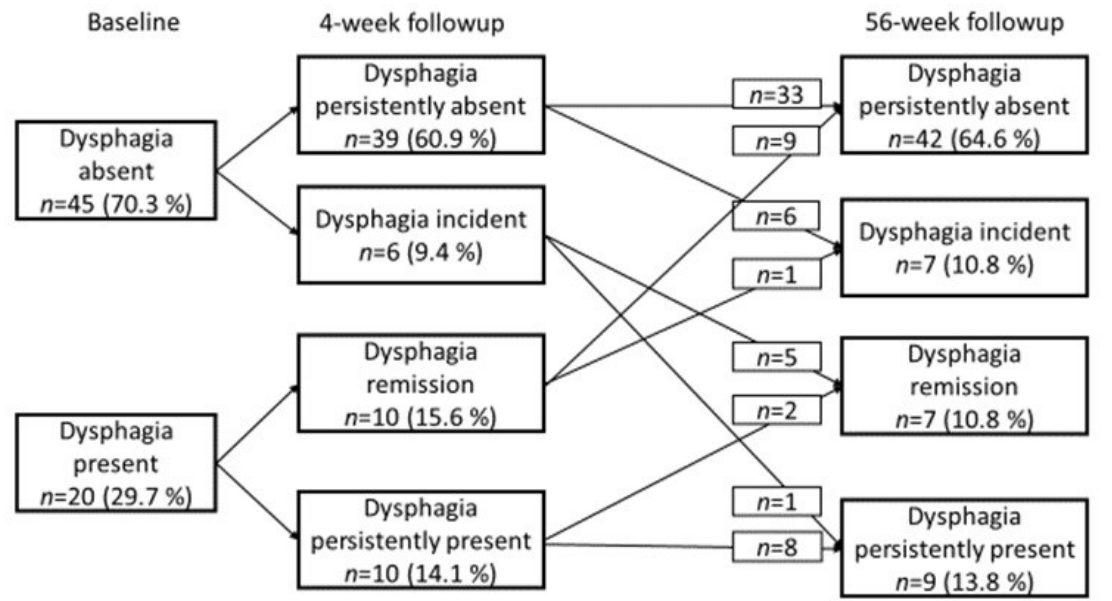
Figure 1. Course of dysphagia during a 56-weeks follow-up period. At 4-week-follow-up, signs of dysphagia were persistently absent in 39 patients (61%), remitted in 10 patients (15%), were incident in 6 patients (9%), and were persis- tently present in 10 patients (15%). At 56-week follow-up, signs of dysphagia were persis- tently absent in 42 patients (64%), remitted in 7 patients (11%), were incident in 7 patients (11%) and were persistently present in 9 patients (14%). There were no significant differ- ences in the dysphagia severity level ( χ 2 (2) = 129, p = 0.524) across the three time points. As illustrated in Table 2, signs of dysphagia were related to low HGS at baseline ( p = 0.012) and at 56-week follow-up ( p = 0.043), low 30-CST at baseline ( p = 0.046) and at 4- week ( p = 0.024) and 56-week ( p = 0.002) follow-up, and low 4MGS at 56-week follow-up ( p = 0.021). Table 3 shows that the likelihood of presenting signs of dysphagia in the oc- currence of probable sarcopenia was up to 3 times higher at baseline and 4-week follow up (ORs ranging from 1.38–3.56), and about 4 to 8 times higher at 56-week follow-up (ORs ranging from 3.79–8.14). Patients with signs of dysphagia had lower swallow activity and functional perfor- mance status at all three time points and showed poorer nutritional status at baseline and 56-week follow-up than patients without signs of dysphagia (Table 2). Table 3 displays that higher levels of swallow activity and functional performance and better nutritional status appeared protective for signs of dysphagia with ORs ranging from 0.81–0.98 at baseline and 4-week follow-up, and from 0.56–0.96 at 56-week follow-up. Signs of dys- phagia was not related to comorbidity burden or plasma levels for the four inflammatory biomarkers, except for TNF- α levels at 56-week follow-up, which were significantly higher in patients with signs of dysphagia than in patients without ( p = 0.039) (Table 2).